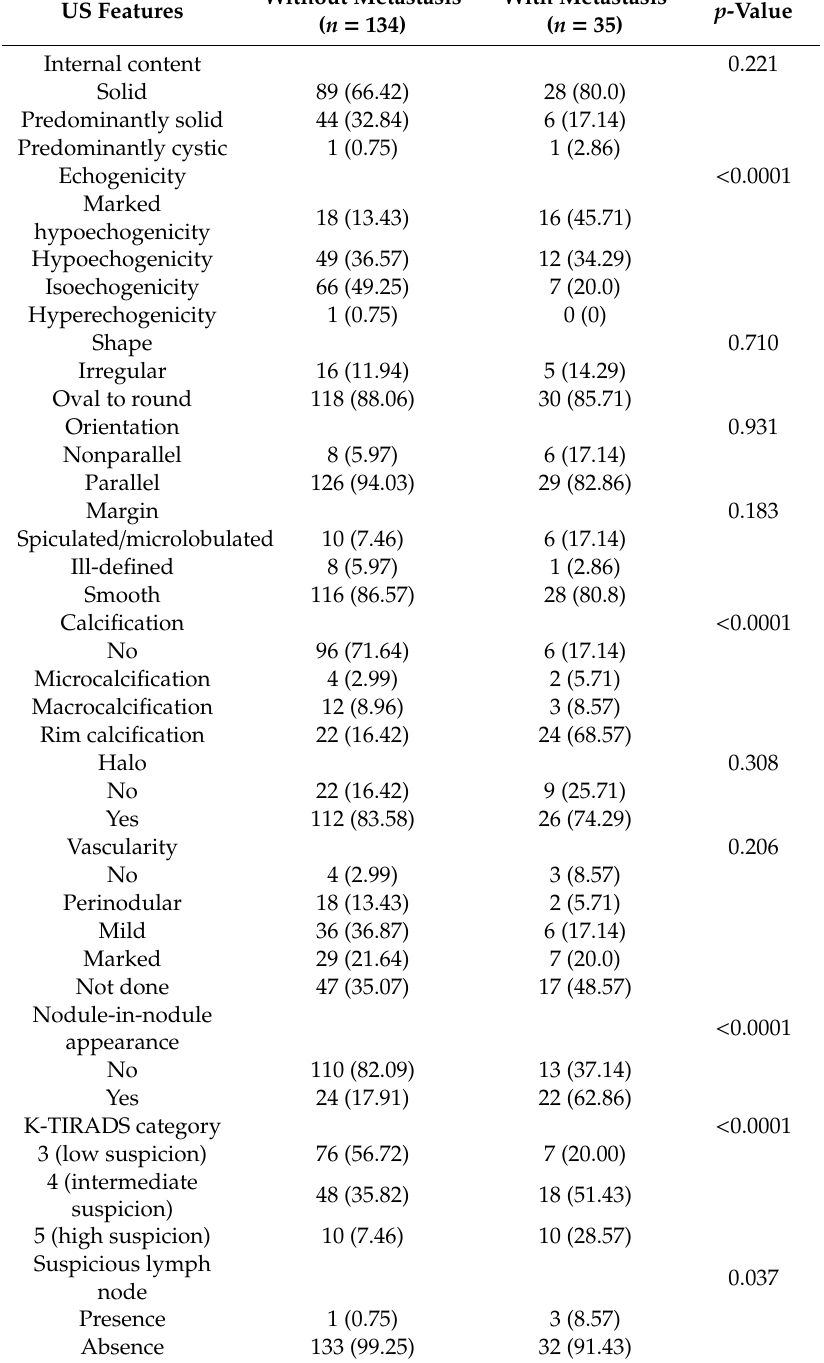
Table 2. Ultrasonographic (US) features of the 169 follicular thyroid carcinomas with and without distant